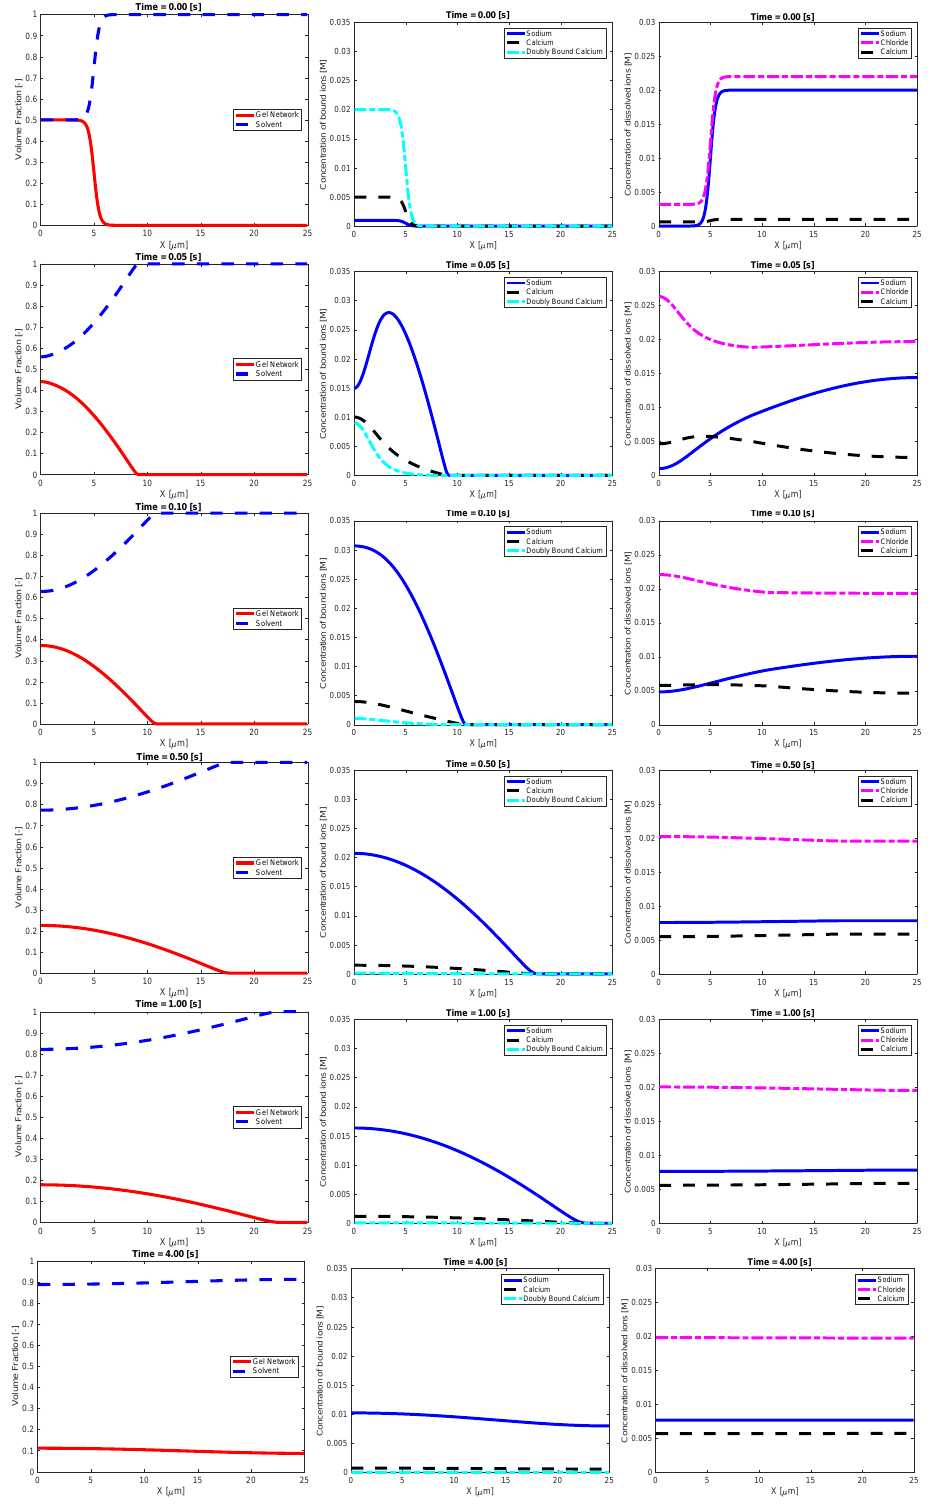
Figure 2. Example time evolution of: volume fraction ( first column ); bound ionic concentrations ( second column ); and dissolved ionic concentrations ( third column